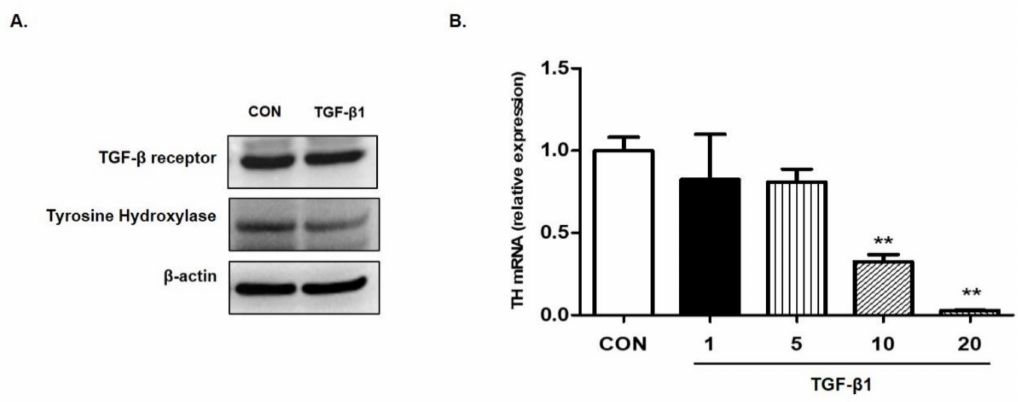
Figure 5. Effect of TGF- β 1 on tyrosine hydroxylase in SH-SY5Y neuroblastoma cells. ( A ) The cells were treated with TGF- β at 10 ng/mL concentrations for 72 h. Cell lysates were analyzed using Western blotting with tyrosine hydroxylase antibodies. ( B ) The cells were treated with TGF- β at indicated concentrations for 24 h. Total RNAs were extracted and expression of tyrosine hydroxylase was detected by real-time PCR. GAPDH was used as a loading control. Data are presented as mean ± SD from three independent experiments. ** p < 0.01 compared with